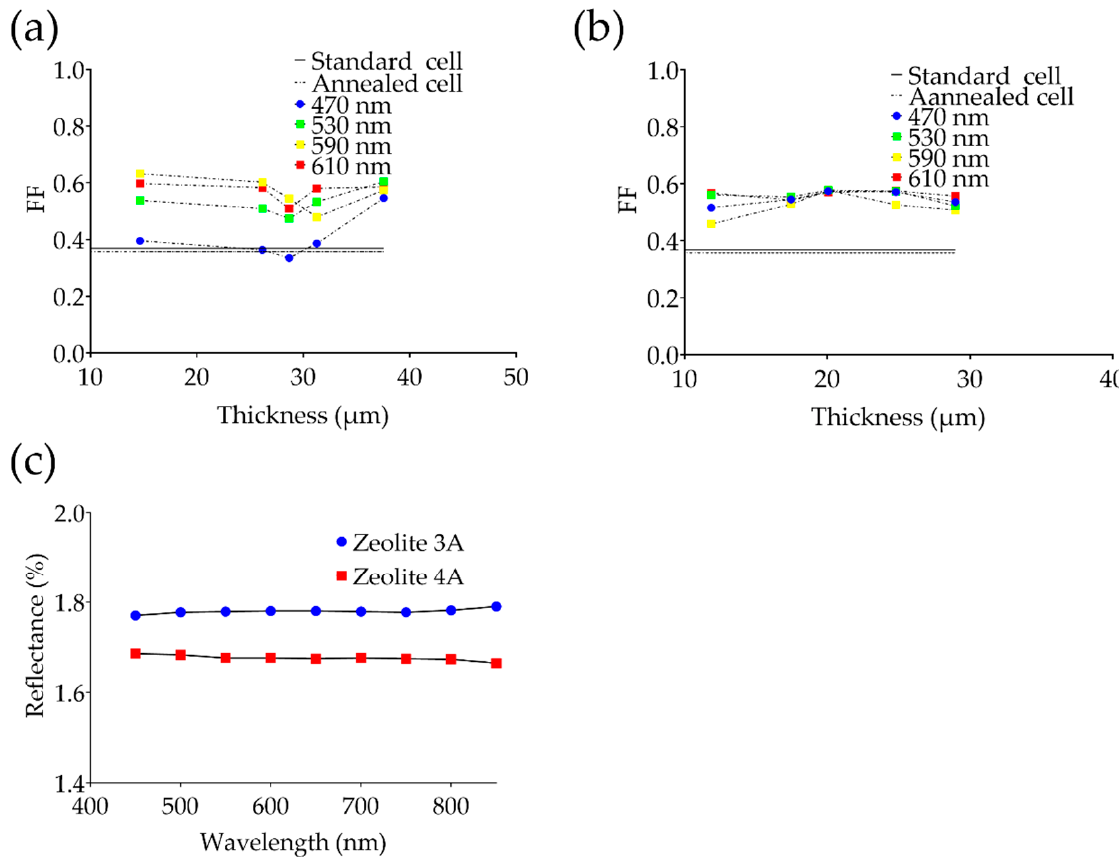
Figure 5. Fill factor vs. thickness for anti-reflective layer ( a ) based on zeolite 3A and ( b ) zeolite 4A. Diffuse reflectance obtained from the thinner ARCs based on zeolite 3A (thickness of 14.65 μ m) and zeolite 4A (thickness of 11.86 μ m) in the range 450–850 nm ( c ).